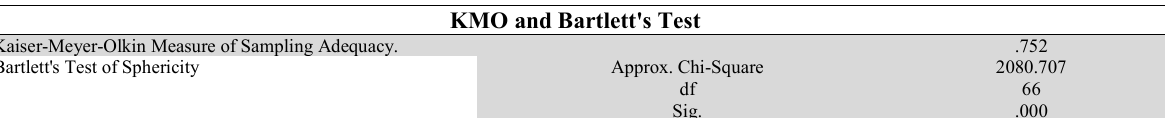
KMO and Bartlett’s Test Kaiser-Meyer-Olkin Measure of Sampling Adequacy.